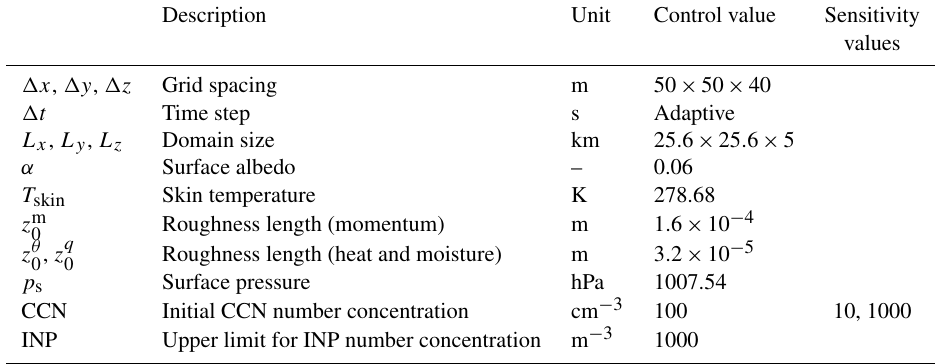
INP Upper limit for INP number